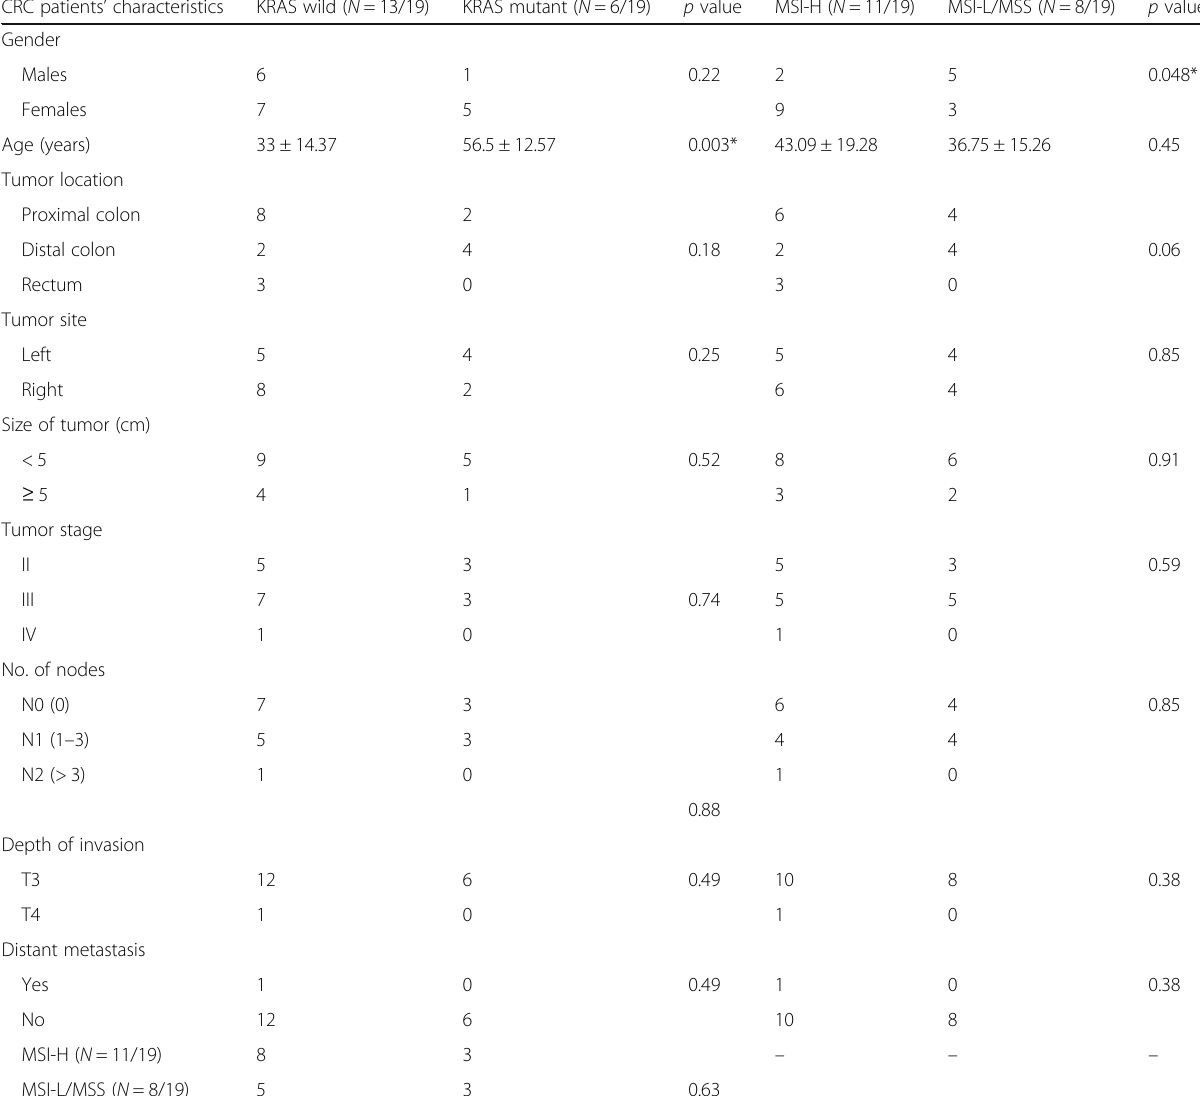
Table 3 Correlation of patients ’ clinicopathological features with KRAS mutational status and MSI status CRC patients ’